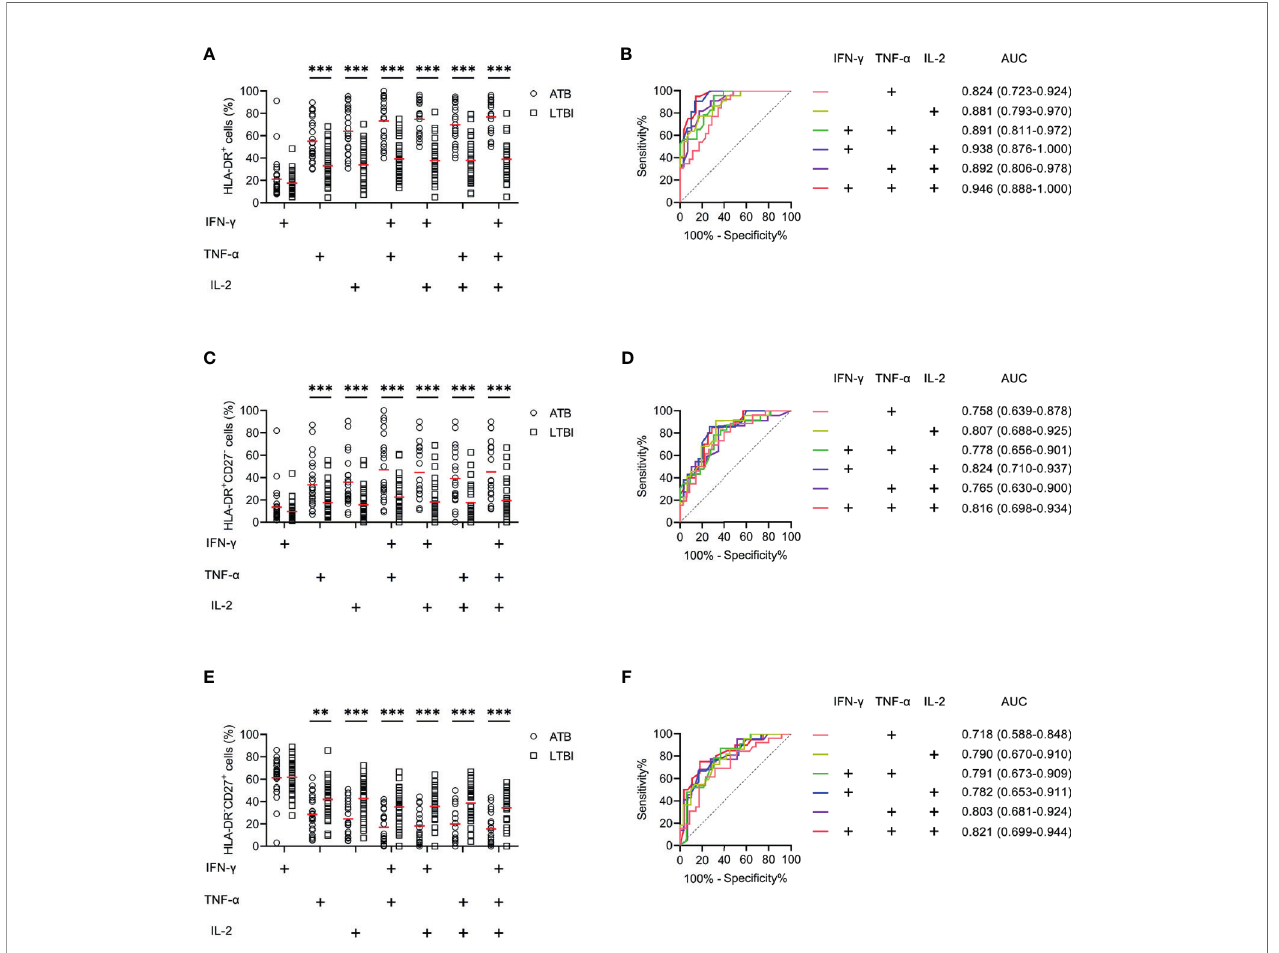
FIGURE 5 | The performance of HLA-DR on MTB-speci fi c cells in distinguishing ATB patients from LTBI individuals in Caidian cohort. (A) Aligned dot plots showing HLA-DR expression on MTB-speci fi c cells in ATB patients and LTBI individuals. Horizontal lines indicate the medians. (B) ROC analysis showing the performance of HLA-DR expression on MTB-speci fi c cells in discriminating ATB patients from LTBI individuals. (C) Aligned dot plots showing the proportions of HLA-DR + CD27 - cells of MTB-speci fi c cells in ATB patients and LTBI individuals. Horizontal lines indicate the medians. (D) ROC analysis showing the performance of the proportion of HLA-DR + CD27 - cells of MTB-speci fi c cells in discriminating ATB patients from LTBI individuals. (E) Aligned dot plots showing the proportions of HLA-DR - CD27 + cells of MTB-speci fi c cells in ATB patients and LTBI individuals. Horizontal lines indicate the medians. (F) ROC analysis showing the performance of the proportion of HLA-DR - CD27 + cells of MTB-speci fi c cells in discriminating ATB patients from LTBI individuals. ** P < 0.01, *** P < 0.001 (Mann-Whitney U test). MTB, Mycobacterium tuberculosis ; ATB, active tuberculosis; LTBI, latent tuberculosis infection; AUC, area under the